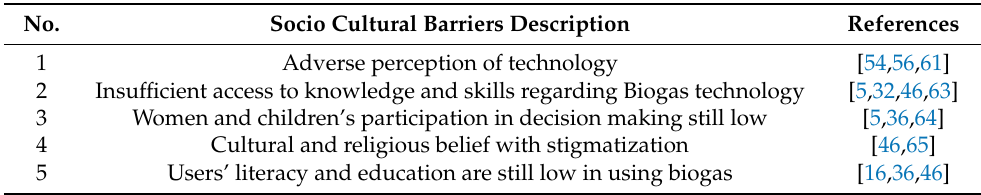
Table 3. Biogas development in Indonesia faces social and cultural obstacles.